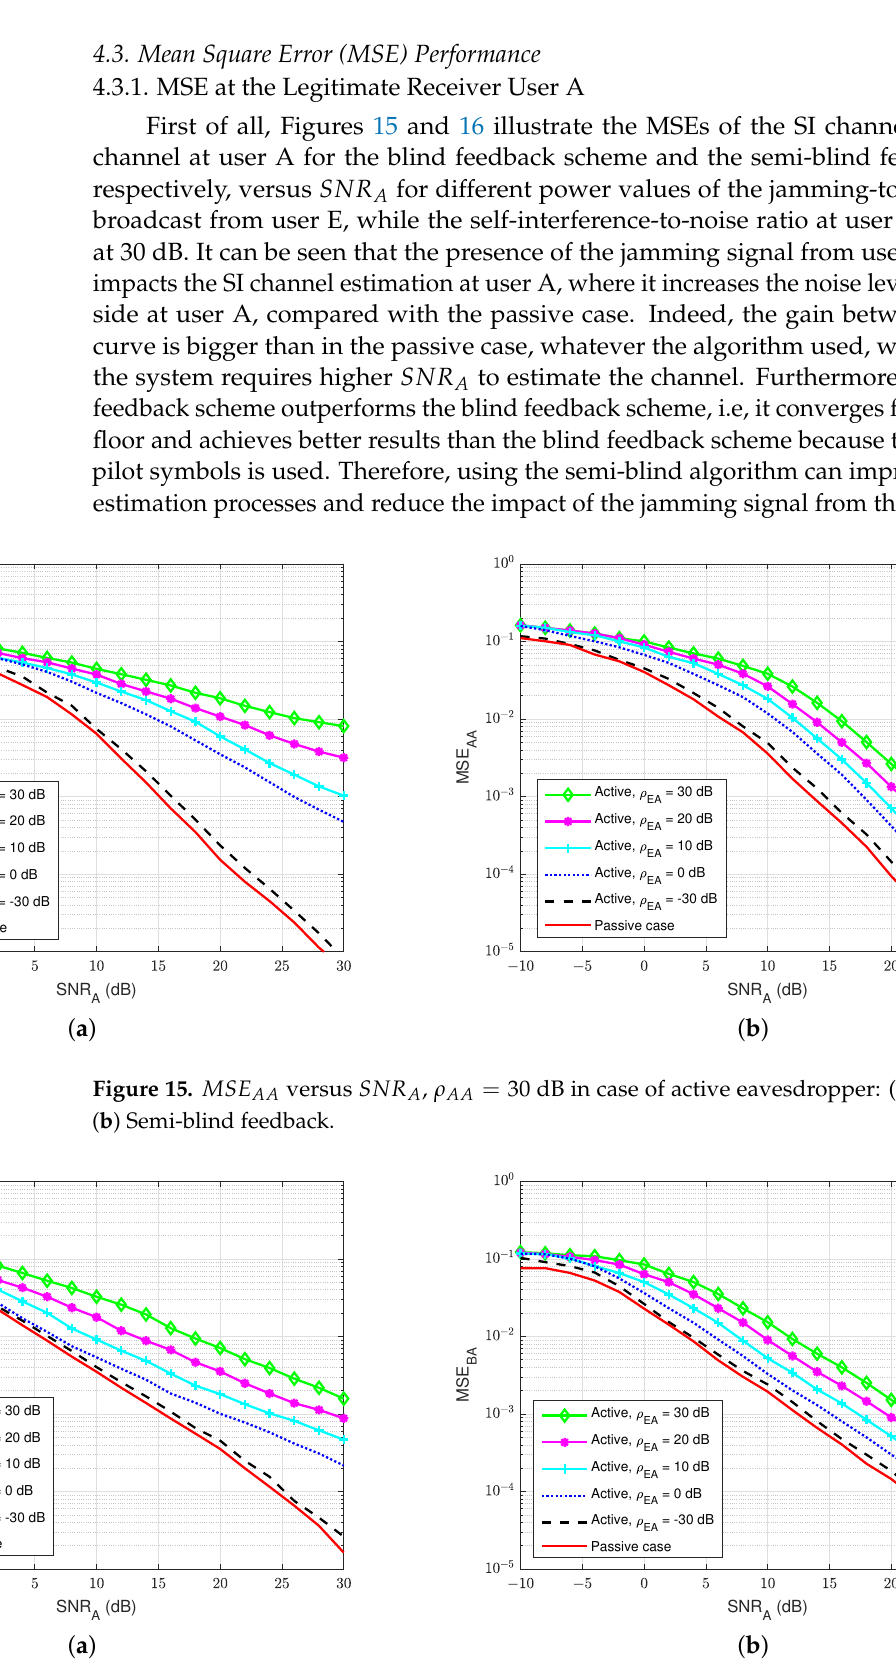
Figure 16. MSE BA versus SNR A , ρ AA = 30 dB in case of an active eavesdropper: ( a ) Blind feedback; ( b ) Semi-blind